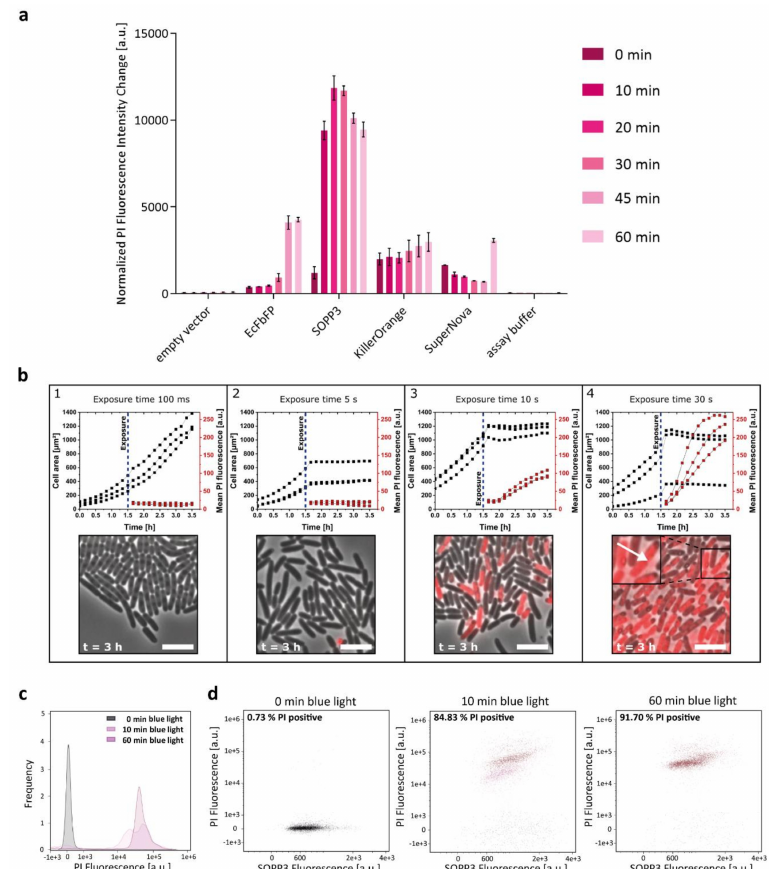
Figure 2. Quantitative in vivo phototoxicity studies of genetically encoded PSs using the propidium iodide (PI) cell death assay. ( a ) For the PI-based cell death assay, E. coli cells carrying the respective pET28a( + ) derivatives were adjusted to an OD 580nm of 0.5 in 1x PI assay buffer (pH 7.4) and illuminated with low light intensities (~10 mW cm − 2 ) of blue ( λ max = 447 nm) or orange light ( λ max = 600 nm). The bars indicate the change in PI fluorescence intensity ( λ ex = 535 nm; λ em = 617 nm) in dependence on exposure time. The data were normalized to the amount of functional protein per cell to exclude an influence of different protein accumulation levels. The data represent the mean values of three independent experiments and the error bars indicate the calculated standard deviations. ( b ) Intracellular phototoxicity of SOPP3 in E. coli . Growth and PI fluorescence data of single cells were monitored over time in microfluidic experiments using E. coli pET28a-SOPP3. (1) 100 ms blue light exposure ( λ max = 445 nm) after 1.5 h cultivation time. (2) 5 s blue light exposure after 1.5 h cultivation time. (3) 10 s blue light exposure after 1.5 h cultivation time (4) 30 s blue light exposure after 1.5 h cultivation time. The arrow indicates a position where a cell lysis event resulted in the release of red fluorescent nucleic acids. In each graph, data from three representative microfluidic chambers are shown. Scale bar = 5 µ m. ( c ) Measurement of cell death by PI uptake via flow cytometry (FCM). E. coli cells harboring the expression vector pET28a-SOPP3 were analyzed for fluorescence and gated based on forward scatter (FSC) and side scatter (SSC) to exclude cell debris and accumulation of cells. Samples for FCM were prepared as described for the PI-based cell death assay. The propidium iodide fluorescence intensity of each cell was measured using a 561 nm-laser (and a 611 / 31 nm (red) bandpass filter) and plotted using a log scale. The data shown in the histogram represent the frequency of cellular PI signal intensities for SOPP3 producing E. coli cells before (0 min) and after 10 and 60 min of blue light illumination. ( d ) For quantitative analysis of ROS-mediated cell death, the SOPP3 fluorescence of E. coli cells was analyzed with a 488 nm-laser, detected by a 528 / 46 nm bandpass filter and plotted against the PI fluorescence before and after blue light illumination. Dead E. coli cells (presented as red populations) are shifted to higher PI fluorescence values and the percentage of dead cells is displayed in the upper left corner. Living cells are represented as black populations. An empty vector control was also analyzed to exclude a toxic blue light effect on the cells (Supplementary Figure